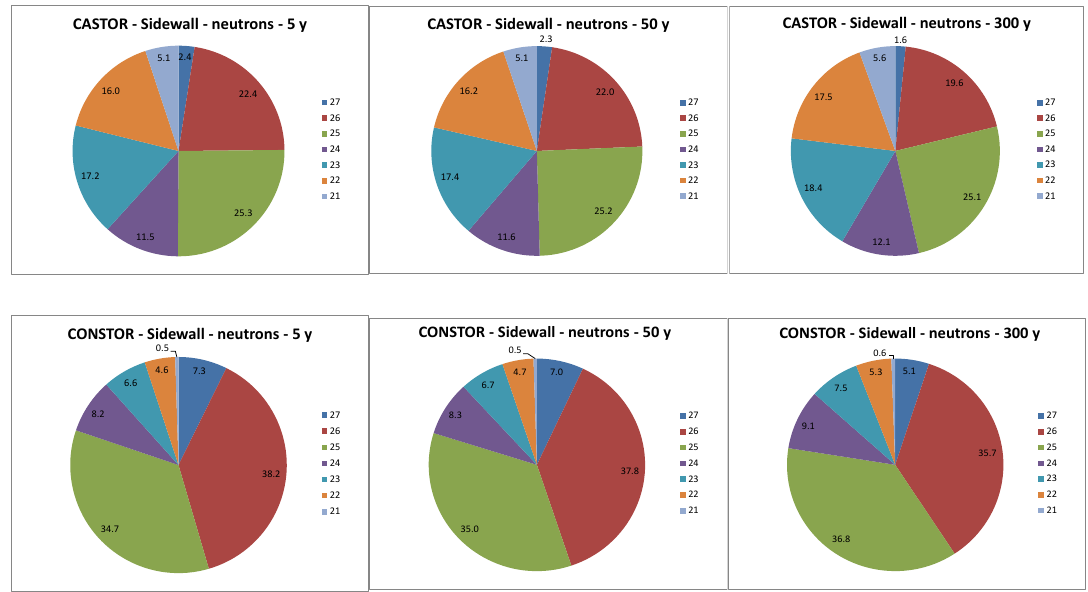
Figure 4. Energy groups that determine the neutron dose rate (low-energy neutrons are efficiently shielded). In the case of neutrons, as can be seen from Figure 4, about 99% of the neutron dose is caused by neutrons of 21 – 27 neutron energy groups (see Table 1 for group energy boundaries). The contributions of the remaining 20 neutron energy groups on the neutron dose rate are negligible. Unlike the contributions of gamma energy groups, the neutron dose rate for all storage periods is determined by the same dominant neutron energy groups.